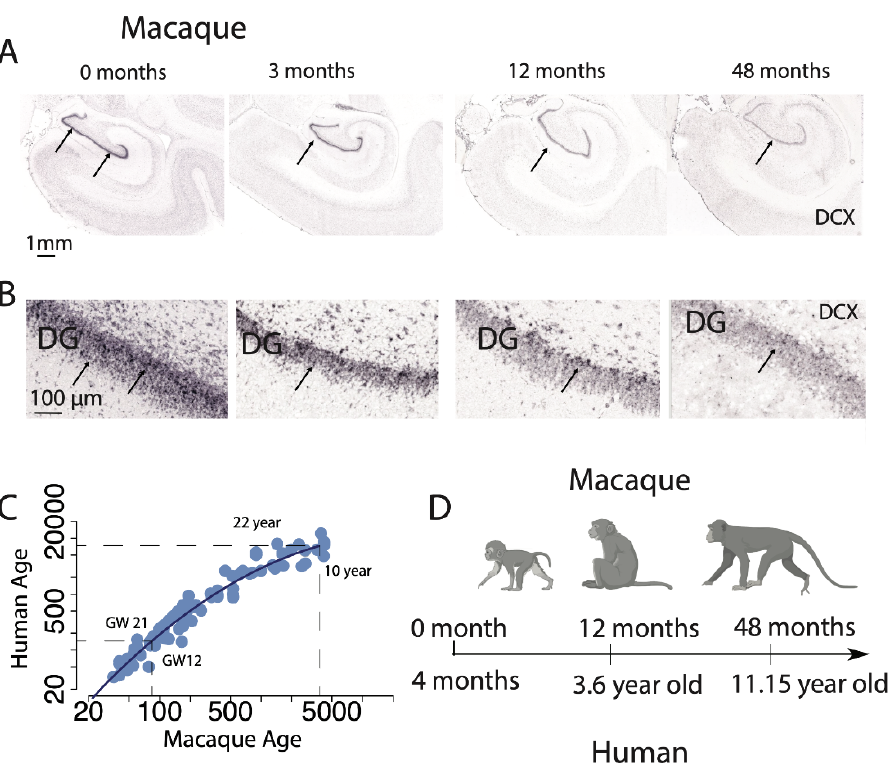
Figure 5. Low ( A ) and high-resolution ( B ) of DCX mRNA expression (arrows) in the macaque hippocampus from 0 months to 48 months after birth. These data show that DCX mRNA expression steadily decreases with age in the dentate gyrus (DG) to relatively low levels at 48 months of age in macaques. ( C ) We extracted time points from temporal variation in transcription, structure, and behavior in humans and macaques to find corresponding ages across these species [39]. According to these data, a macaque at gestational week (GW) 12 is equivalent to a human at GW 21 and, a 10-year-old macaque equates to a 22-year-old human. The identification of corresponding time points permits relating the temporal decline in DCX in across species. ( D ) For example, DCX expression in the DG was rather high between 0 and 3 months of age in macaques, which corresponds to 4 months after birth in humans. By 48 months of age, DCX mRNA sharply declined, which corresponds to 11 years of age in humans. Collectively, observations from mice and macaques pointed to a rapid decline in DCX mRNA during childhood in humans. ISH images are from in situ hybridization data made available by the Allen Brain Institute (http://www.blueprintnhpatlas.org; http://mouse.brain-map.org, accessed on 28 July 2021). Some panels are from BioRender.com, accessed on 28 July